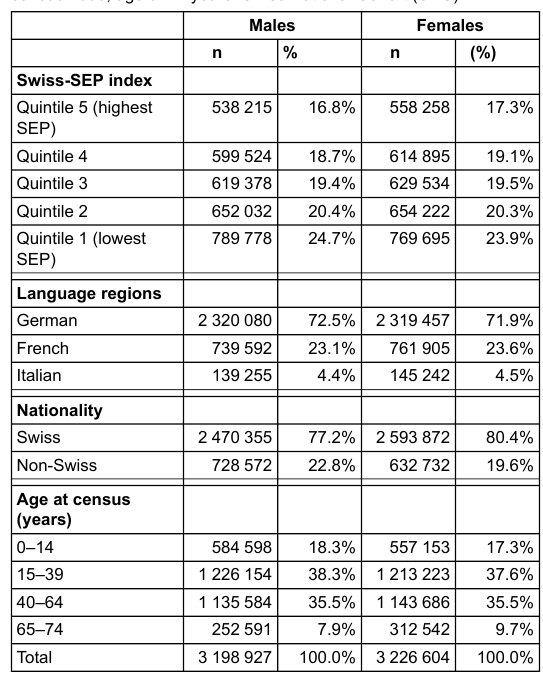
Table 3: Sociodemographic characteristics of the study population at census 2000, age 0–74 years: Swiss National Cohort (SNC).